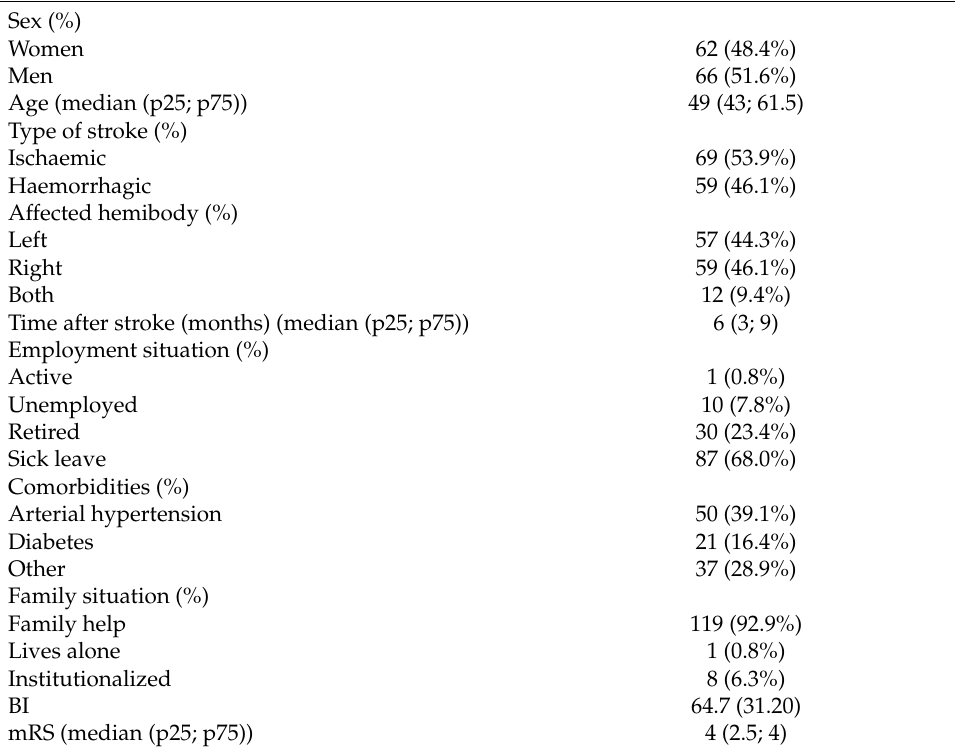
Figure 1. Flowchart: progress of patients through the study. Table 2. Socio-demographics and clinical characteristics of the